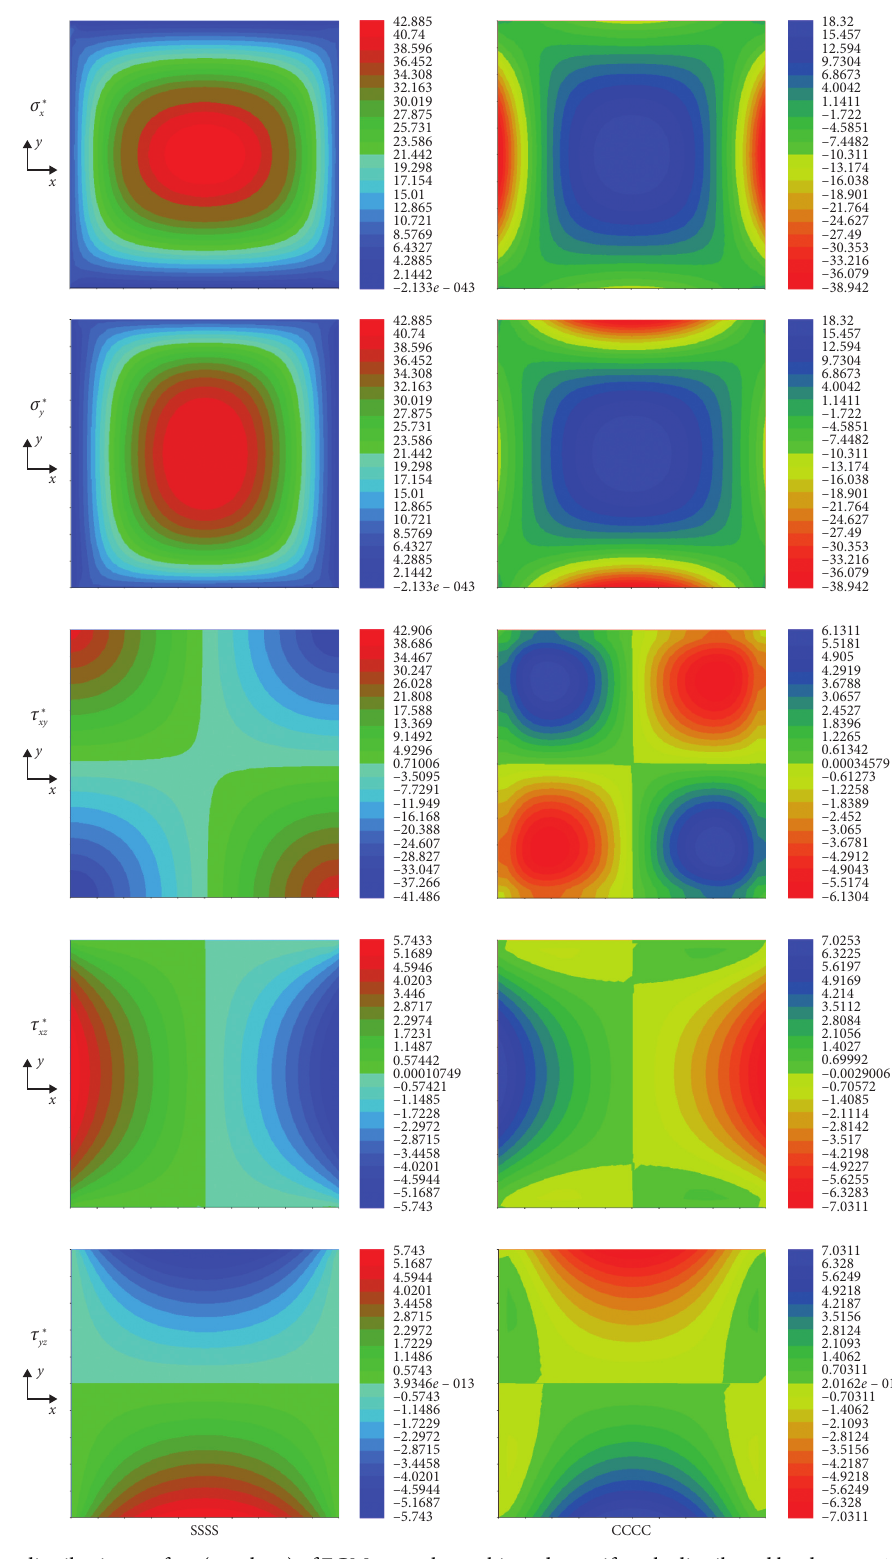
� 1, a / h � 10, a / b � 1, and 0 , n